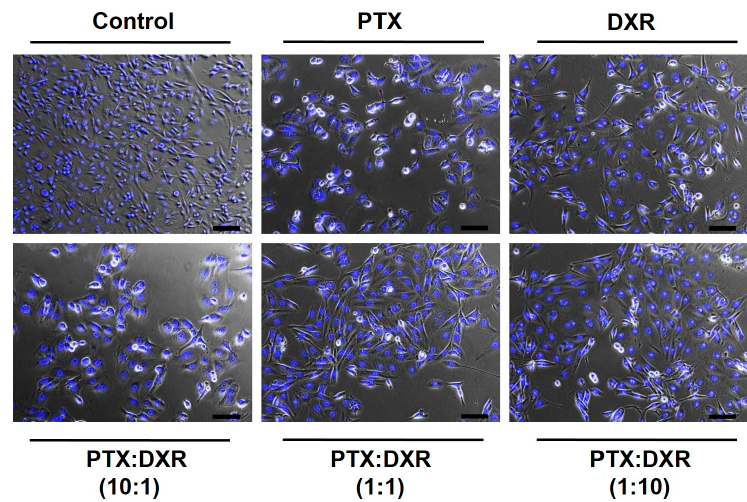
Figure 3. Merge of phase-contrast and fluorescence photomicrographs of MDA-MB-231 cell line after different treatments at concentration of 70 nM for 48 h. In the control group, cell shapes were intact and with higher density. On all treated groups, it was observed enlarged and flattened cells, matching the phenotypic morphology of senescence. Round cells, characteristic of mitotic arrest can be observed on groups treated with PTX and PTX:DXR at 10:1 molar ratio. Nuclei were stained with Hoescht 33342. Images are representative of three independent experiments. Amplification 10×, scale bar = 100 μ m. Abbreviations: DXR, doxorubicin; PTX, paclitaxel.